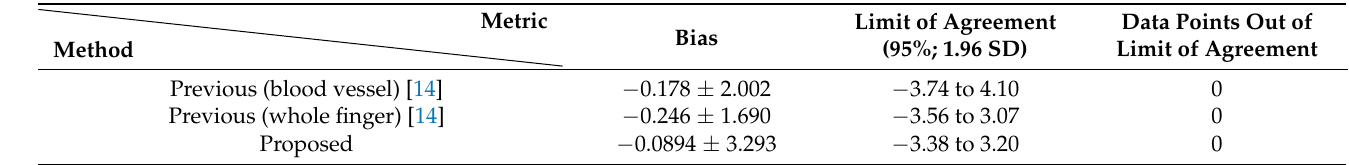
Table 8. Bland-Altman-analysis-based comparison between this study and the previous study for estimating SpO 2